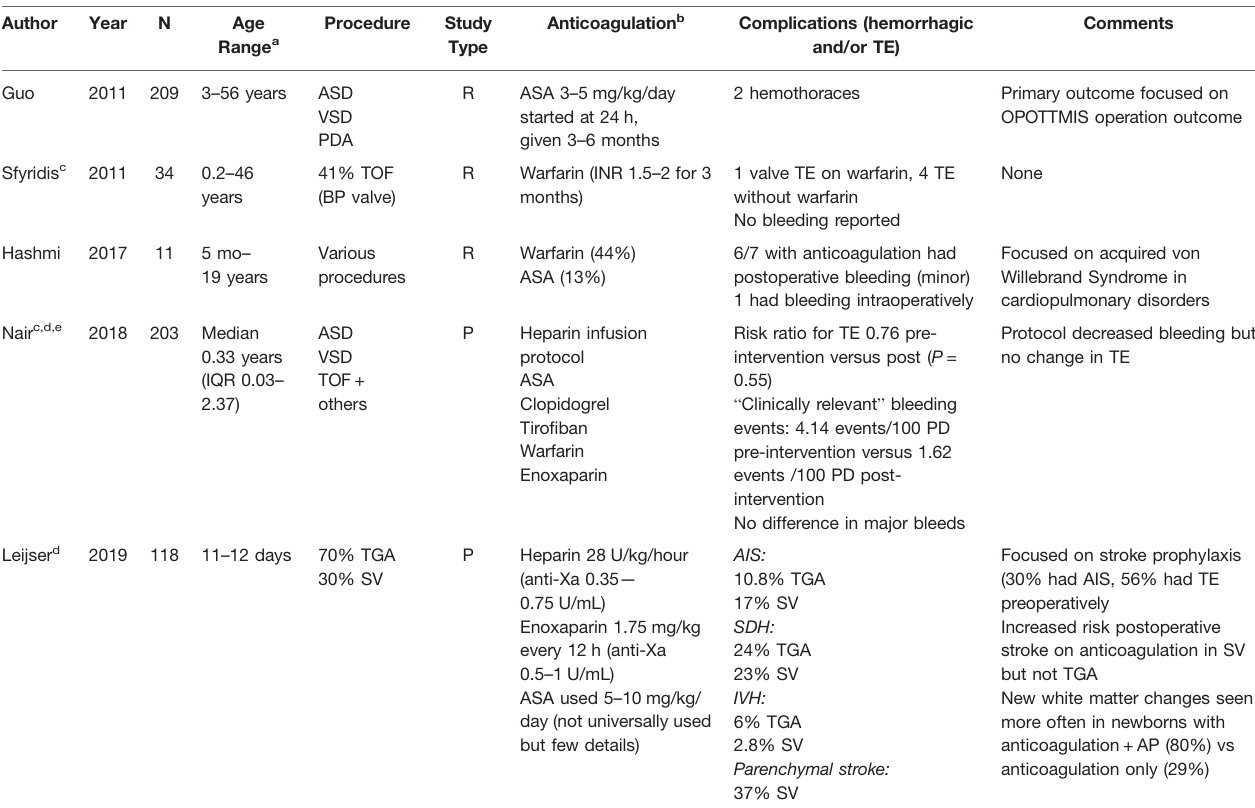
TABLE 4 | Study descriptions for septal defects, tetralogy of Fallot, and transposition of the great